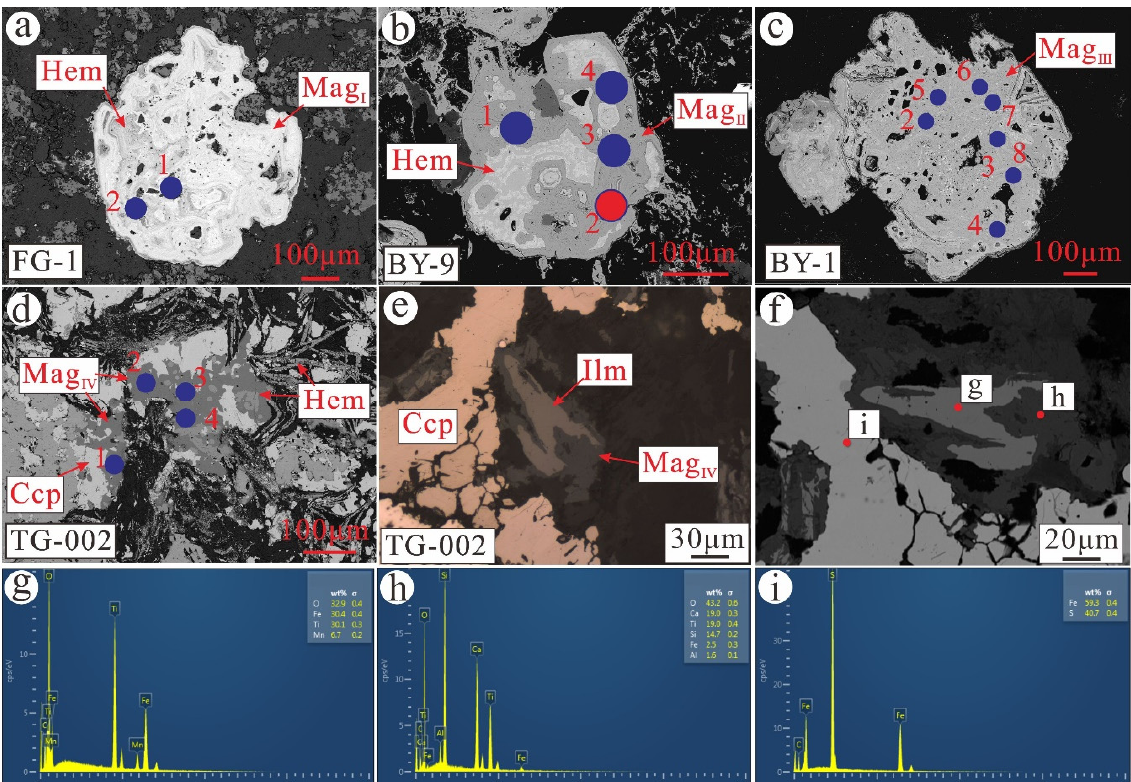
Figure 6. ( a ) BSE image of Mag I from sample FG-1; ( b ) BSE image of Mag II from sample BY-9; ( c ) BSE image of Mag III from sample BY-1; ( d ) BSE image of Mag IV from sample TG-002; ( e ) replacement texture of Mag IV in reflected-light photomicrograph from sample TG-002; ( f ) replacement texture of Mag IV in BSE image from sample TG-002; ( g ) EDS analysis on ilmenite; ( h ) EDS analysis on magnetite; ( i ) EDS analysis on chalcopyrite.